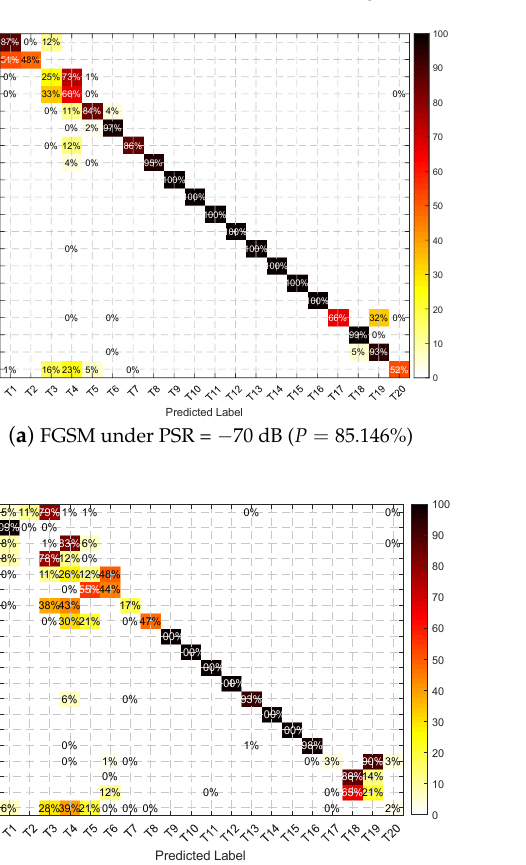
Figure 18. Recognition effect of the system with and without AT when SNR = 35 dB for Dataset 2.